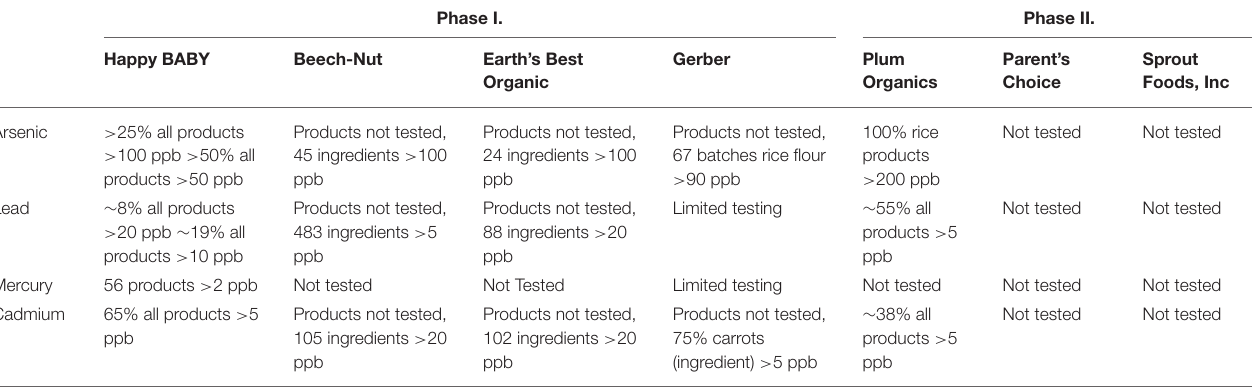
TABLE 1 | Summary of findings from U.S. congressional subcommittee on economic and consumer policy reports on heavy metal content of top seven baby food manufacturers in the United States. Phase